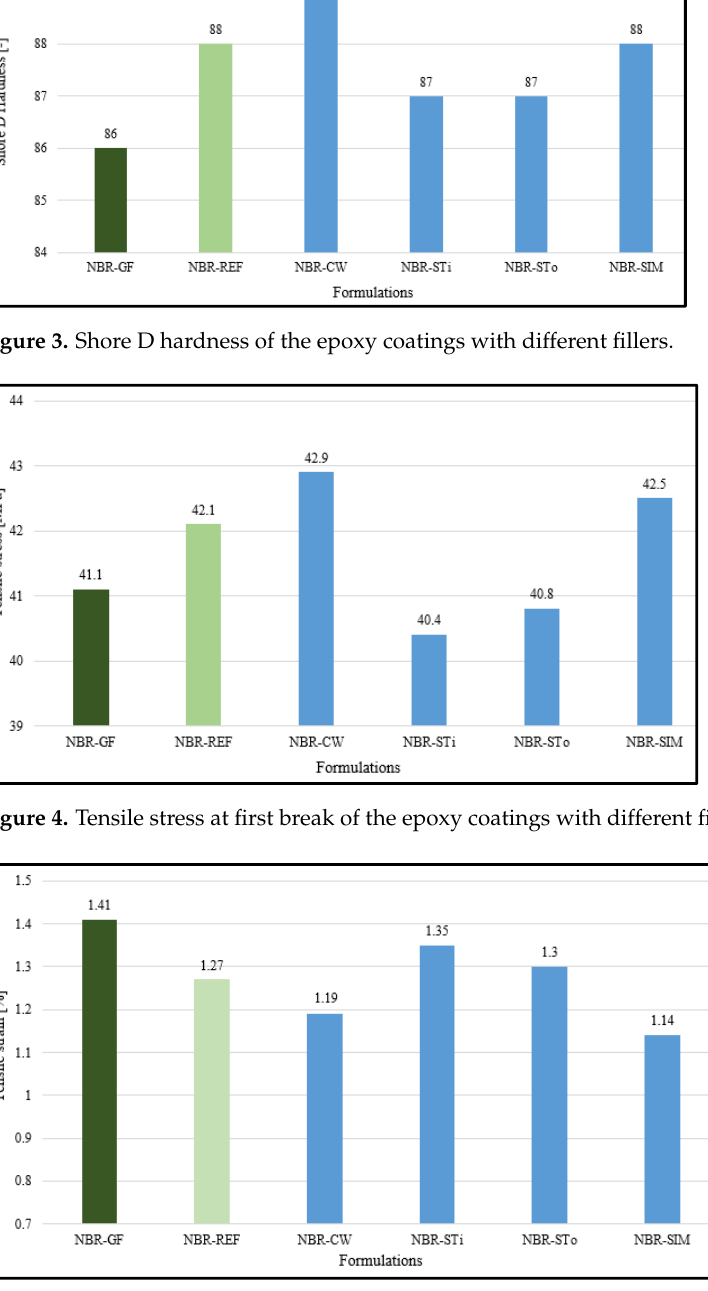
Figure 5. Tensile strain at first break of the epoxy coatings with different fillers.